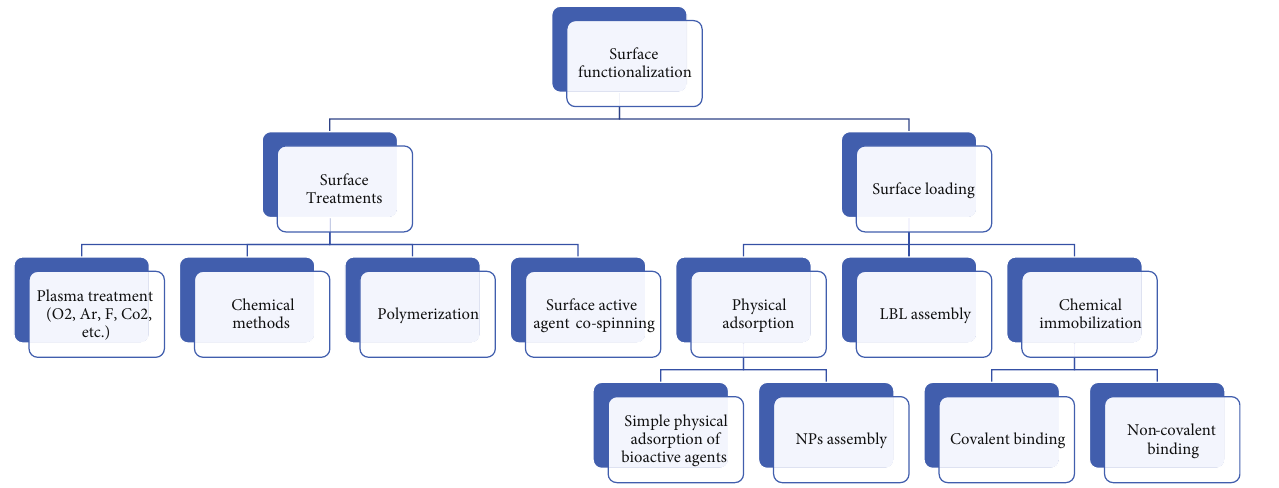
Figure 4: Di ff erent surface modi fi cation methods used on electrospun fi